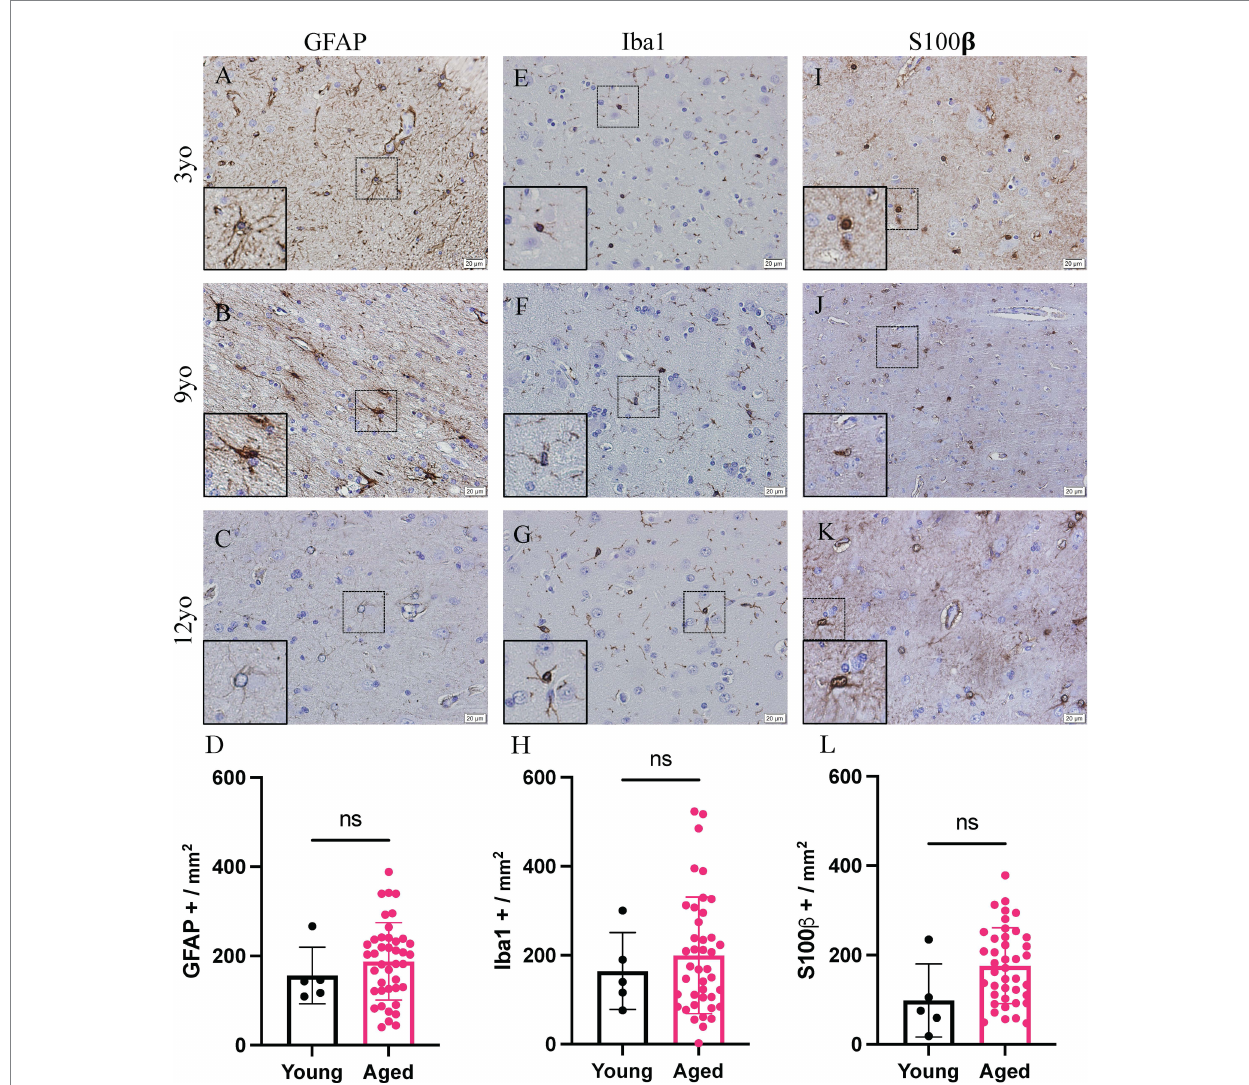
FIGURE 1 Increased glial reactivity in the cortex of aging canines. Increase no significant change was detected in GFAP+ cells (A–D) , IBA1+ cells (E–H) or S100 β positive cells (I–L) compared to young canines. n = 5 young; n = 41 aged. Scale bar = 20 μM Unpaired t -test ( D : t = 0.8882; H : t = 0.5822; L : t = 1.946. df = 44), error bars = SEM, p < 0.05. p values: D = 0.4348, H = 0.5634, L = 0.0580, ns =